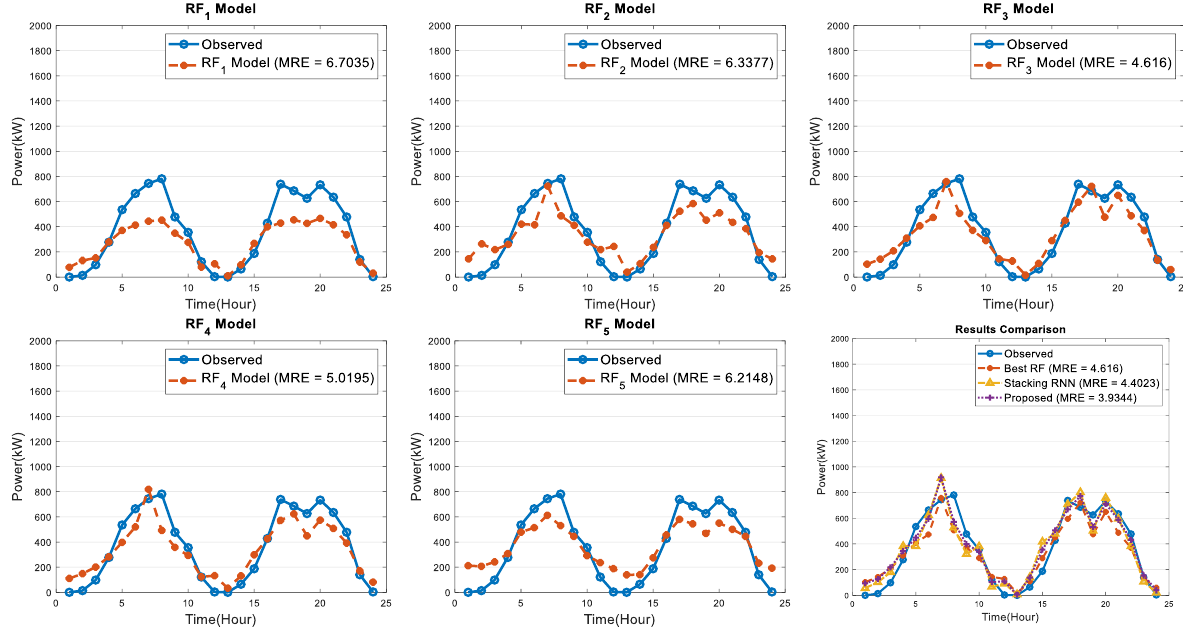
Figure 12. Results for one-day-ahead PV power forecasting for heavy-cloudy weather conditions. Figure 13 shows the results for the RF models and the proposed regression-based ensemble forecasting method for rainy conditions. The RF 3 has the lowest MRE value of 1.87% compared to the other RF models, but the stacking RNN outperforms the best RF model with an MRE value of 1.76%. Nevertheless, the proposed ensemble method has the best MRE value of 1.59%.